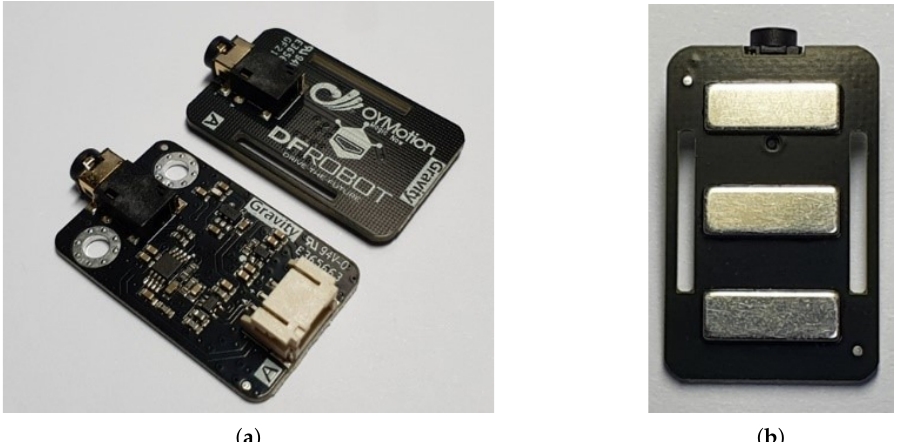
Figure 4. sEMG sensor used in the proposed HGR system: ( a ) configuration of sensor; ( b ) front view of electrode